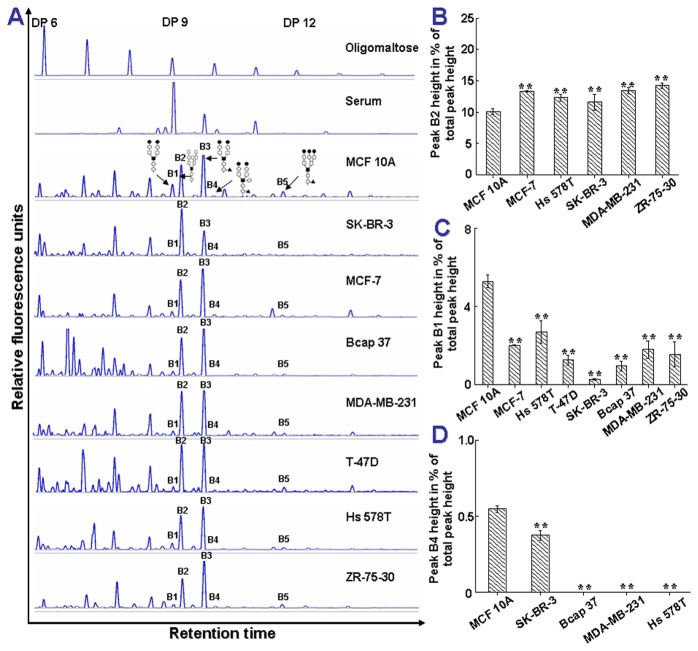
The significantly changed N-glycans of the membrane proteins of human breast cancer cell lines.(A) The representative N-glycan profiles of membrane proteins from human breast cancer cell lines (n=7). MCF 10A: from breast fibrocystic disease as a non-tumorigenic epithelial cell line; SK-BR-3, MCF-7, Bcap 37, MDA-MB-231, T-47D, Hs 578T and ZR-75-30: cancer cell lines; Serum: from healthy humans. (B–D) The statistically significant difference in N-glycan peaks B1, B2, B4 and B5 between MCF 10A and various cancer cell lines. Peak B2 is significantly increased in cancer cell lines compared with MCF 10A. On the contrary, peaks B1 and B4 are dramatically decreased in cancer cell lines. Particularly, peak B4 is completely lost in Bcap 37, MDA-MB-231 and Hs 578T cell lines. The percentages of each specific peak height in the total peak heights are expressed as mean ± SD. Asterisks indicate statistically significant differences between the various cancer cell lines and the MCF 10A cell line (* p < 0.05, ** p < 0.01). Five major glycan peaks B1-B5 in normal control and breast cancer groups were detected. Experiments were repeated three times.